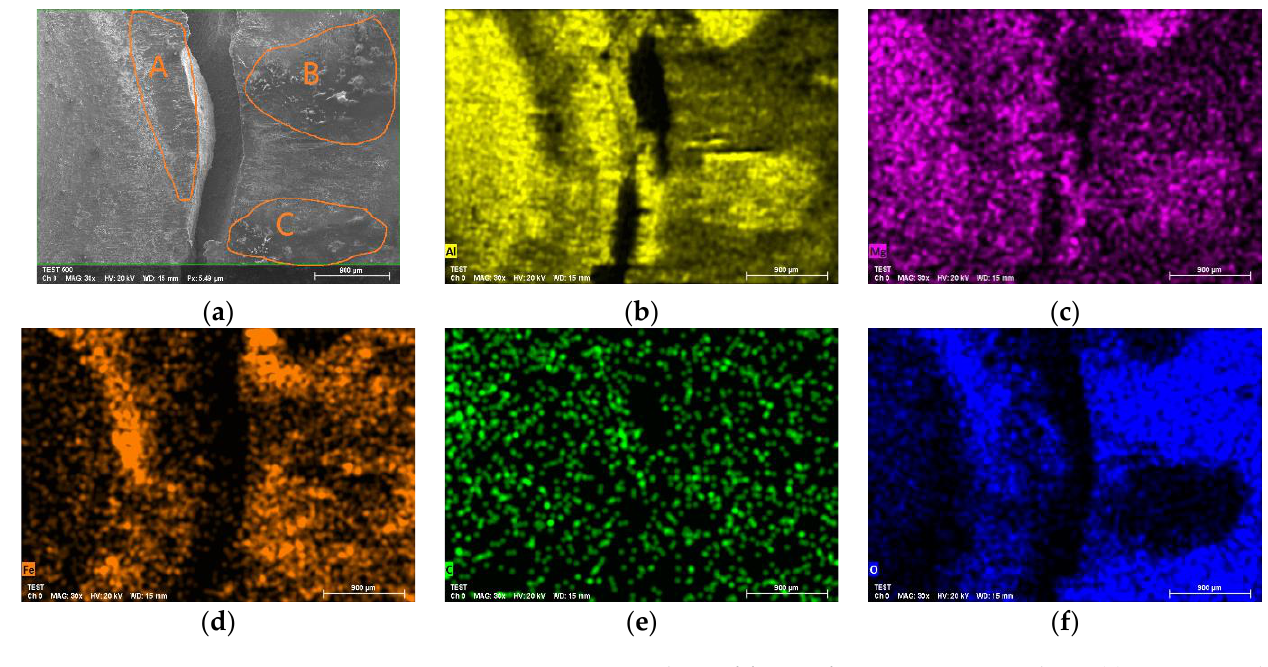
Figure 12. Energy permissive analysis of fatigue fracture in AA5052 sheet: ( a ) Fatigue crack in lower surface of AA5052 sheet (A, B, C are typical serious friction, oxidation, and corrosion areas); ( b ) Distribution of chemical element aluminum; ( c ) Distribution of chemical element magnesium; ( d ) Distribution of chemical element ferrum; ( e ) Distribution of chemical element carbon; ( f ) Distribution of chemical element oxygen.